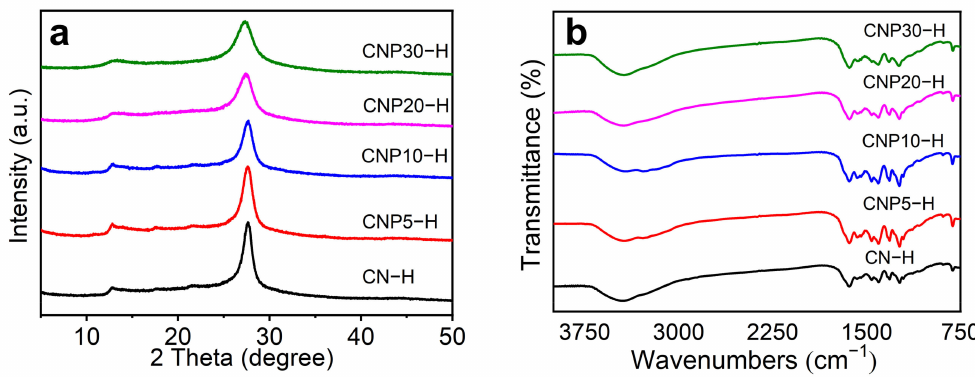
Figure 2. ( a ) XRD patterns and ( b ) FTIR spectra of CN-H and CNPx-H.